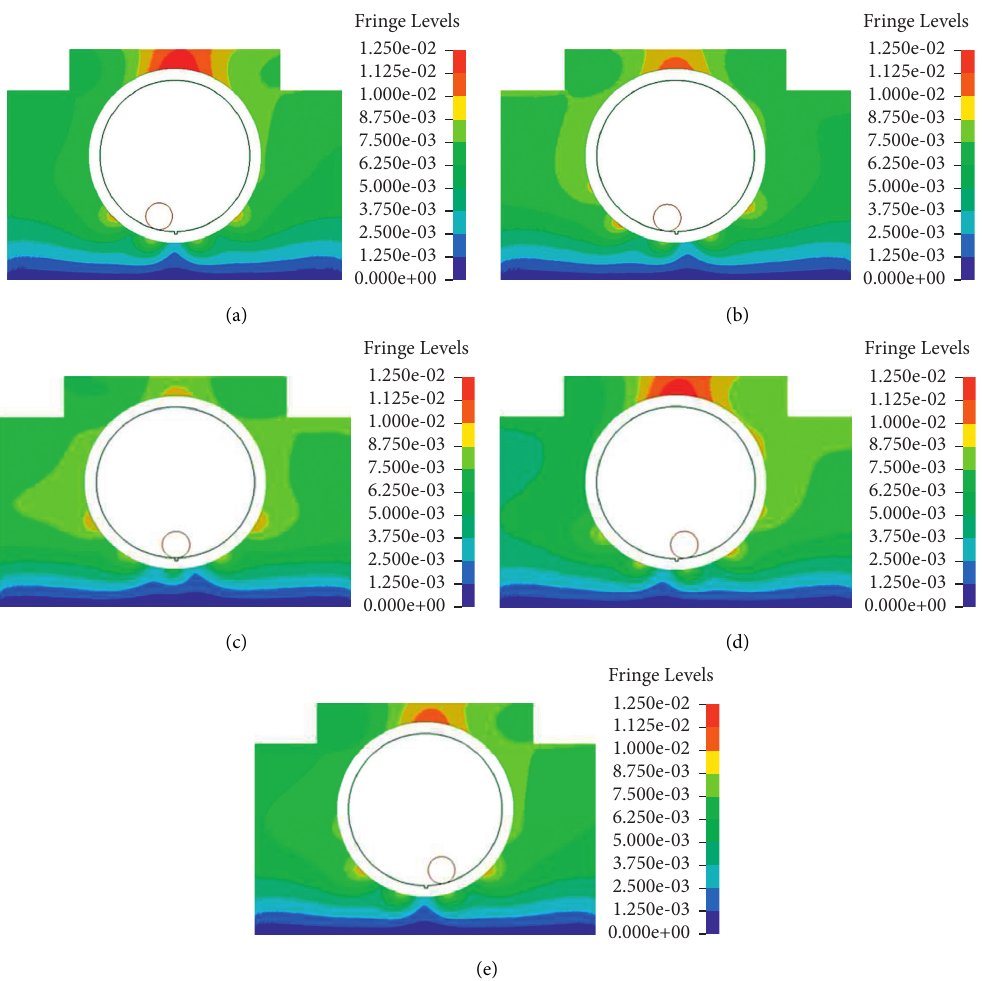
Figure 8: The deformation cloud diagram of the bearing housing while a rolling element is passing through the defect at different time instants: (a) 0.0697s, (b) 0.0712 s, (c) 0.0727s, (d) 0.0742s, and (e)